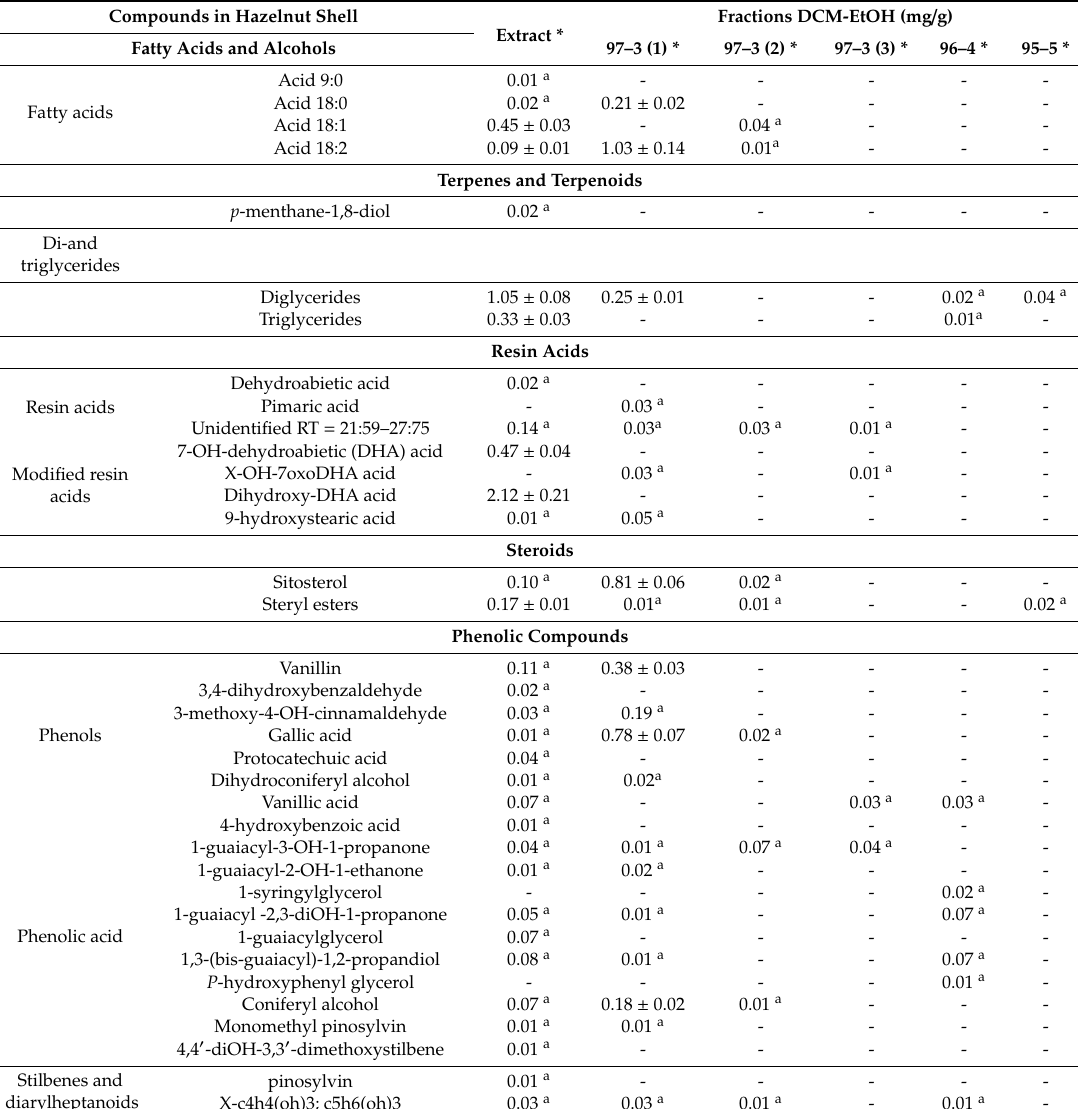
Table 3. Composition of crude HS extract and dichloromethane-ethanol (DCM-EtOH) fractions. Compounds in Hazelnut Shell